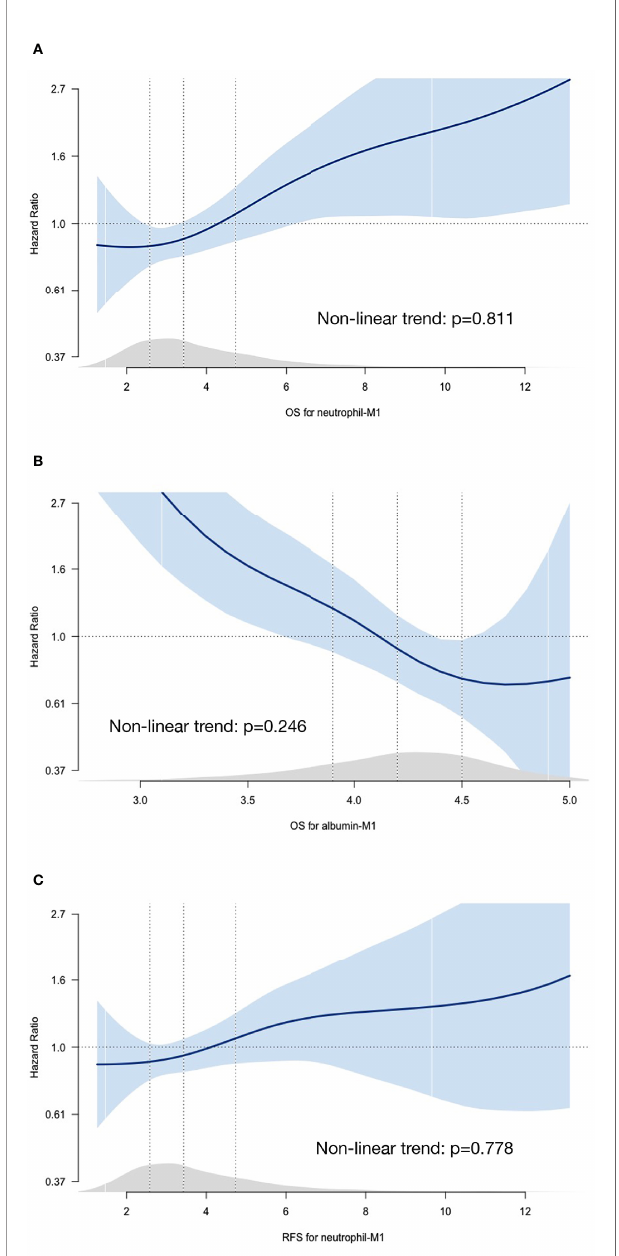
FIGURE 2 | Spline curves for associations between HRs and 1-month absolute values for neutrophil count (A) , lymphocyte count (B) , and albumin level (C) . The blue curves represent penalized smoothing splines for adjusted HRs. Blue-shaded areas represent 95% con fi dence intervals. HRs were estimated using Cox proportional hazards models adjusted for age, sex, pathologic stage for OS and adjusted for age, sex, pathologic stage, body mass index, and extent of gastrectomy for RFS. Light gray areas just above the x-axis represent density plots. Vertical dotted lines indicate the fi rst quartile, median, and third quartile values. (HR, hazard ratio; M1, 1 month; OS, overall survival; RFS, recurrence-free